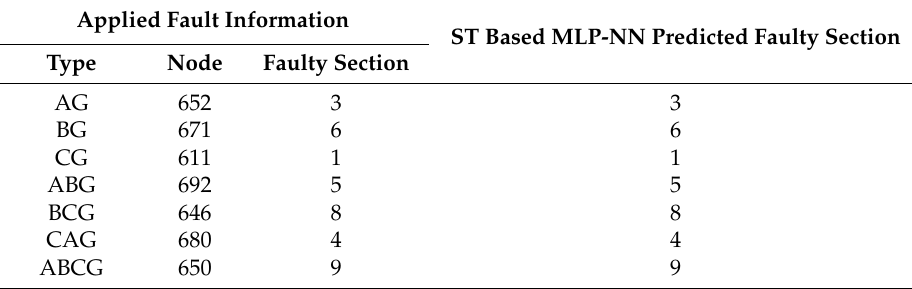
Table 13. Faulty section identification results obtained employing the ST based machine learning tools, for the IEEE thirteen-node test distribution